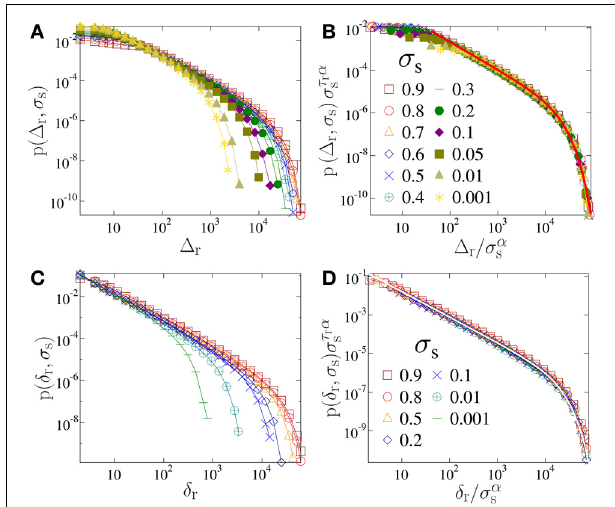
FIGURE 4 | Size distribution of record breaking bursts (A) and their increments (C) for several load values. (B,D) demonstrate that rescaling the distributions with the external load high quality collapse of the curves can be achieved. The continuous lines in (B,D) represent fits with Equation